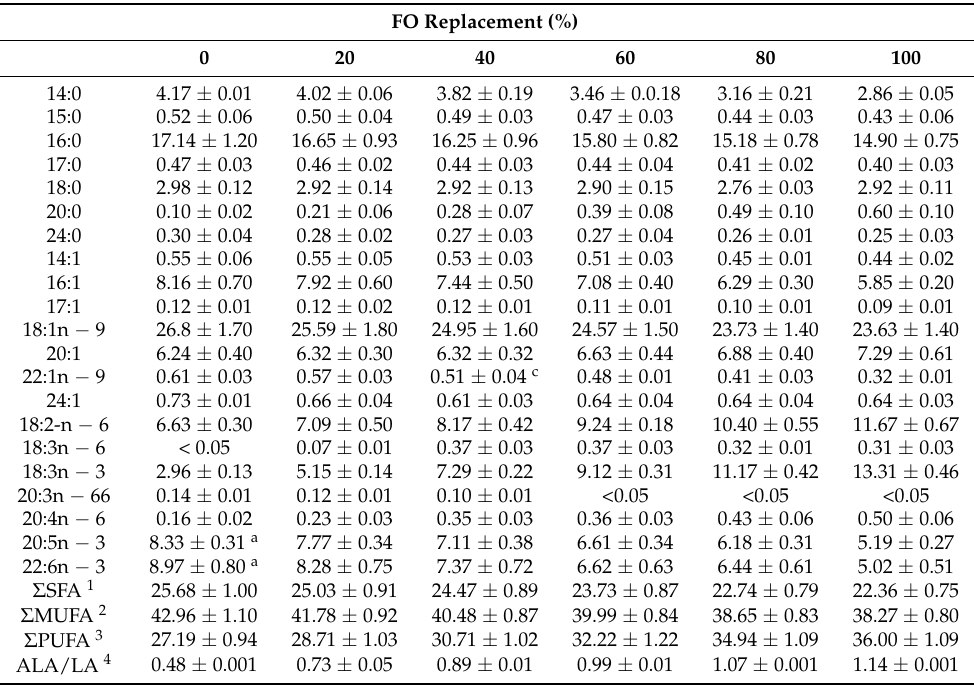
Table 3. Fatty acid profile (% of total lipid content) of the practical diets with different replacements of cod liver oil (FO) with camelina oil (CO).